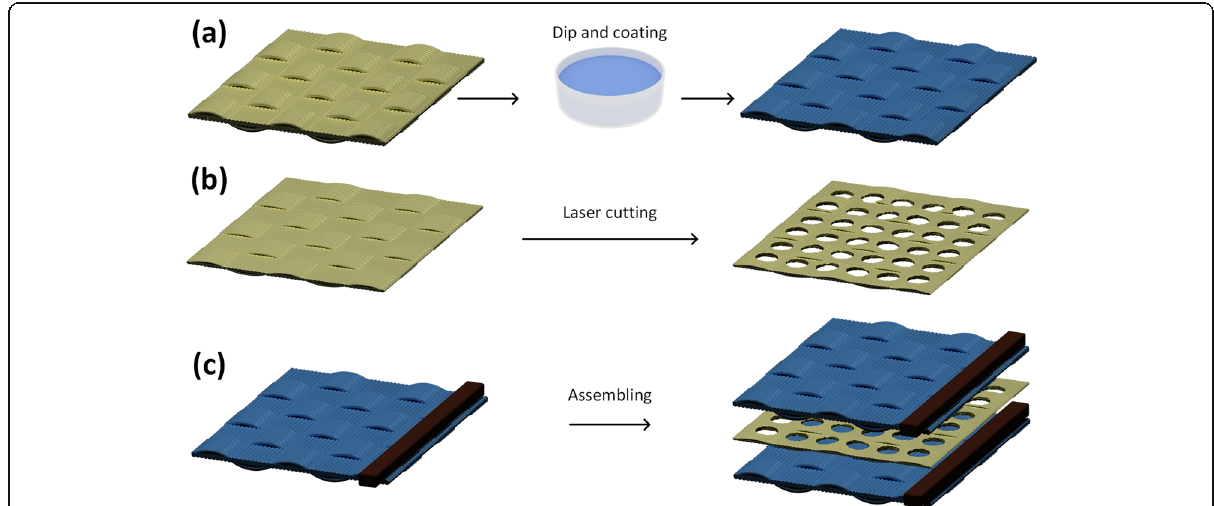
Fig. 1 Fabrication process of the all-textile-based pressure sensor. a The preparation process of AgNW-coated cotton. b The fabrication process of mesh spacer cotton. c The assembling process of pressure